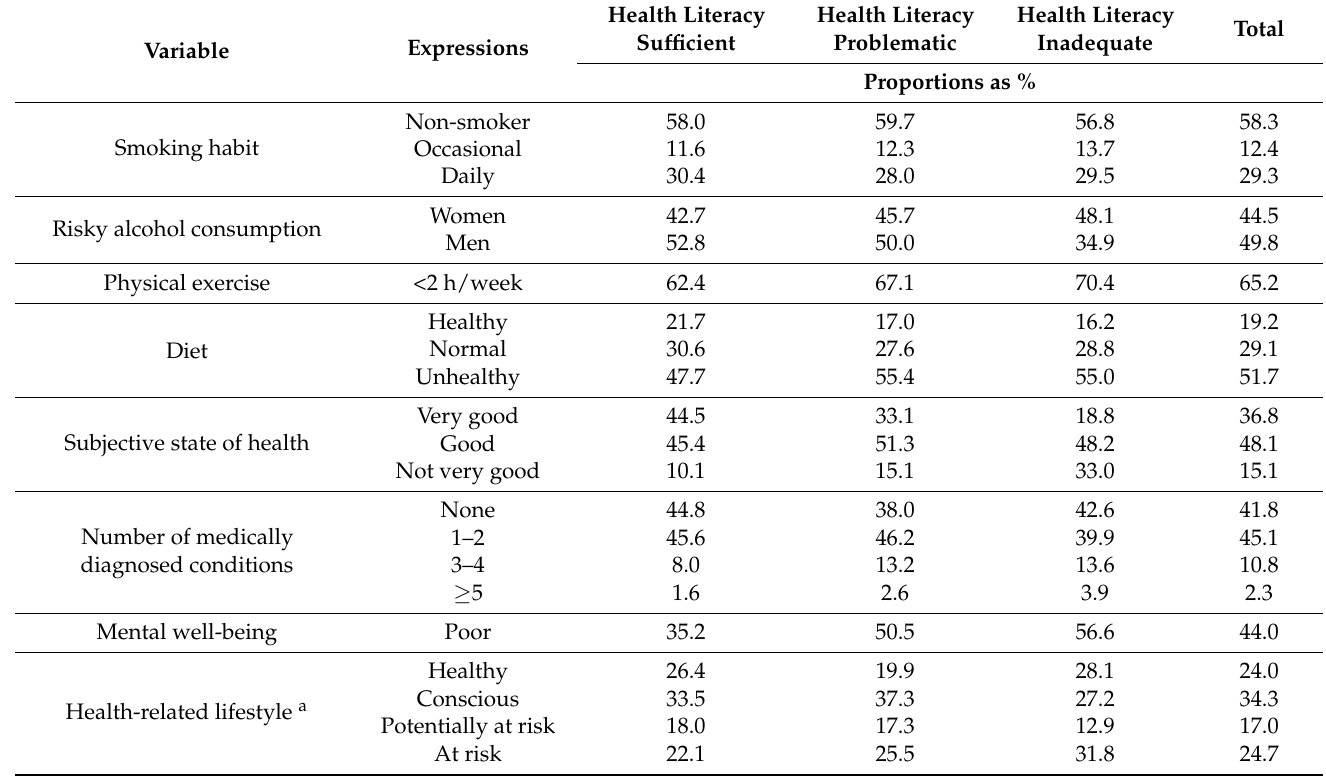
Health Literacy Sufficient Problematic